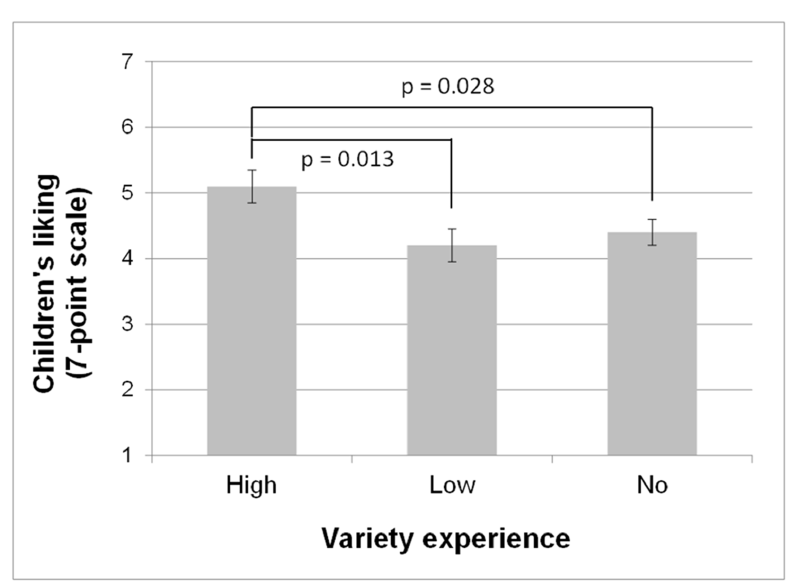
Fig 4. Early experience with high variety of vegetables is associated with higher liking of familiar vegetables. Liking (mean ± SE) at follow-up 3, i.e. when children were on average 6 years old, for the three experimental groups (no, low and high